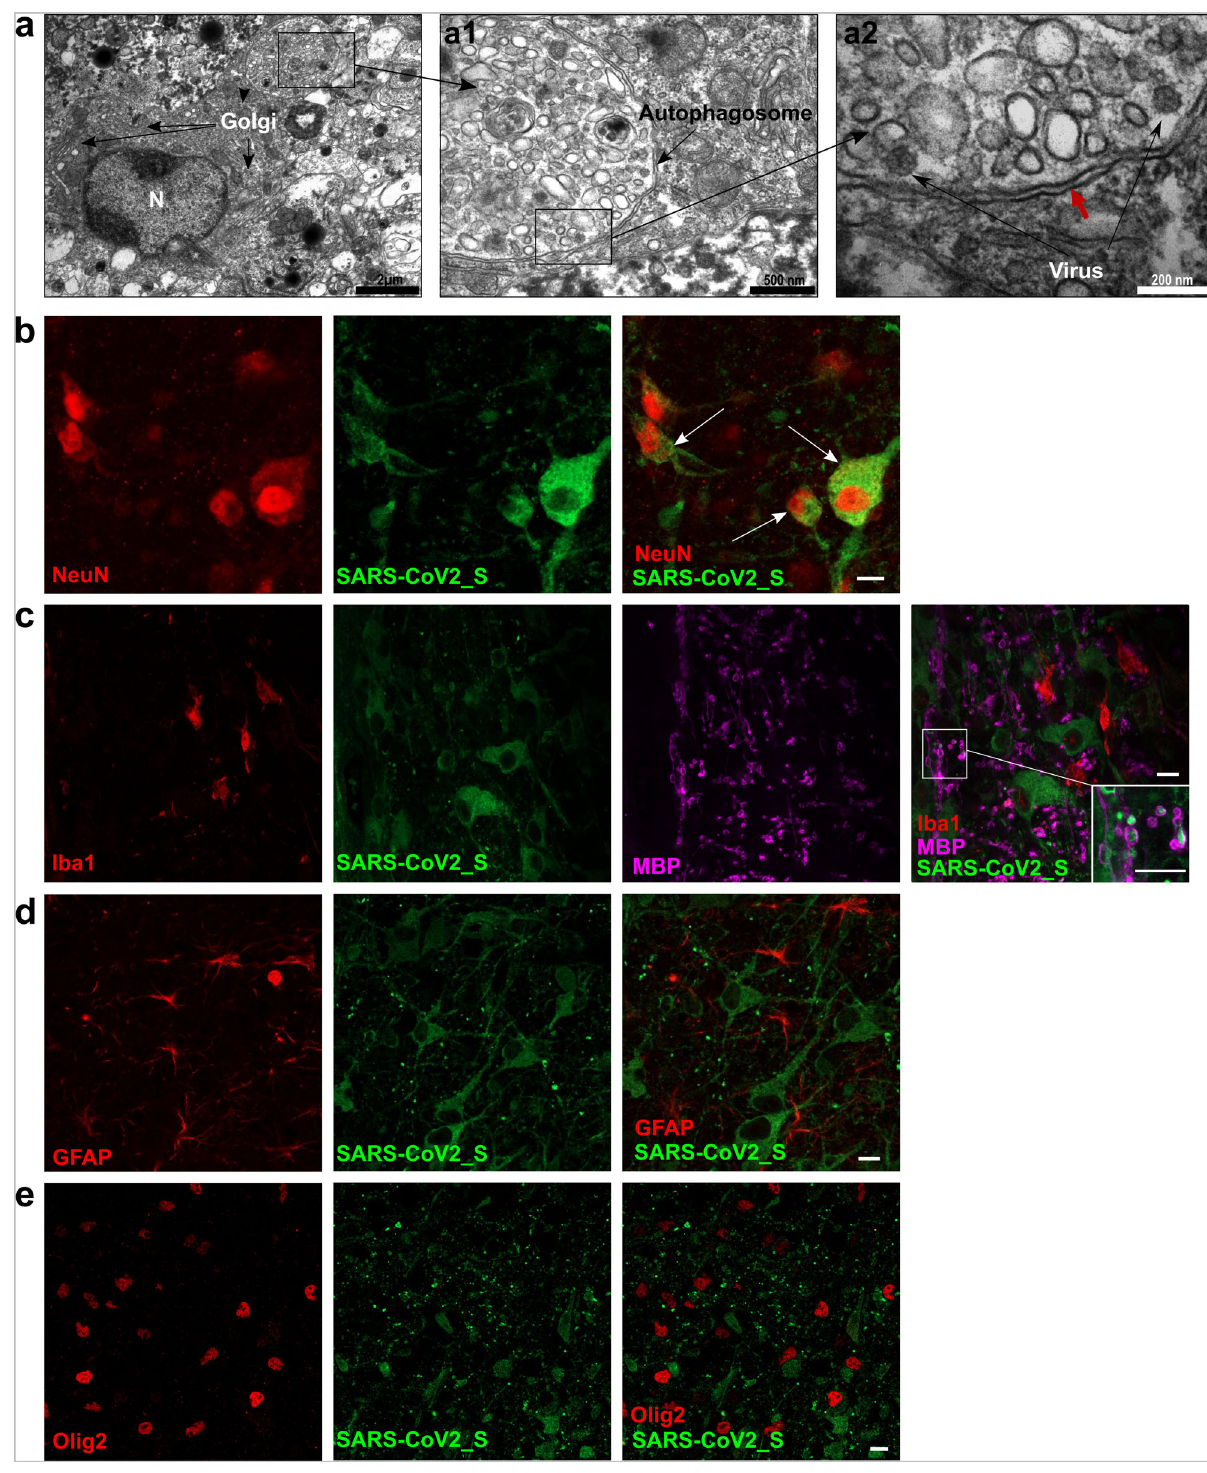
Fig. 5 SARS-CoV-2 tropism in hamster brainstem organotypic cultures during the fi rst 2 days of infection. Cultures were infected with 1000 pfu of SARS-CoV-2 and fi xed at day 2 days post infection. a Transmission electron microscopy (TEM) analysis of a brainstem slice showing an infected neuron with a large Golgi apparatus. a1 , 2 Enlargement of the autophagosome containing viral particles (white arrows). The double membrane of the autophagosome is indicated with the red arrow. The results are representative of two independent experiments. b – e Brainstem slices stained with antibodies anti-SARS-CoV-2_S, b anti-NeuN, c anti-Myelin Basic Protein (MBP), and ionized calcium-binding adaptor molecule 1 (Iba1), d anti-glial fi brillary acidic protein (GFAP), and e anti-Olig2. The immuno fl uorescence staining analysis was performed by confocal microscopy and is representative of three independent experiments. Scale bar 10 µ m.